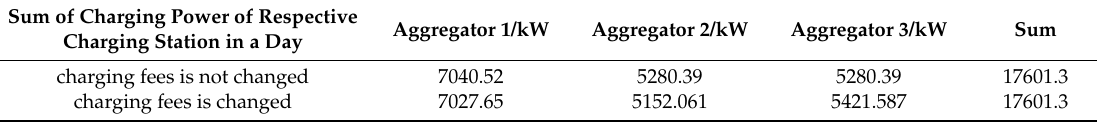
Table 3. Charging power comparison of each charging station before and after the policy.